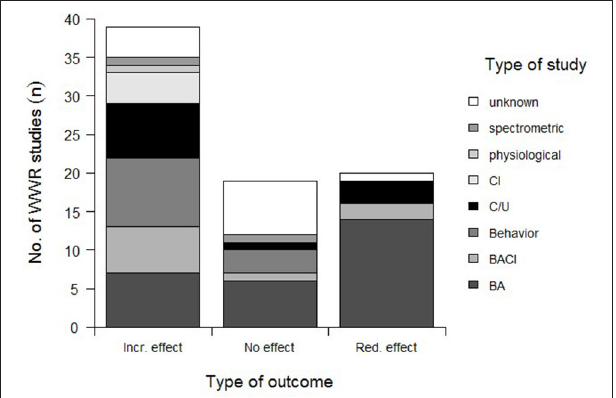
FIGURE 1 | Findings of the effectiveness of Wildlife Warning Reflectors (WWR) to reduce Wildlife-Vehicle collisions (WVC). Study designs included before-after (BA), control-impact (CI), before-after-control-impact (BACI), or cover/uncover (C/U) study approaches, as well as behavioral, physiological, and spectrometric evaluations. Unknown study designs ( N = 12) did not provide information on the applied design or the information was not accessible.